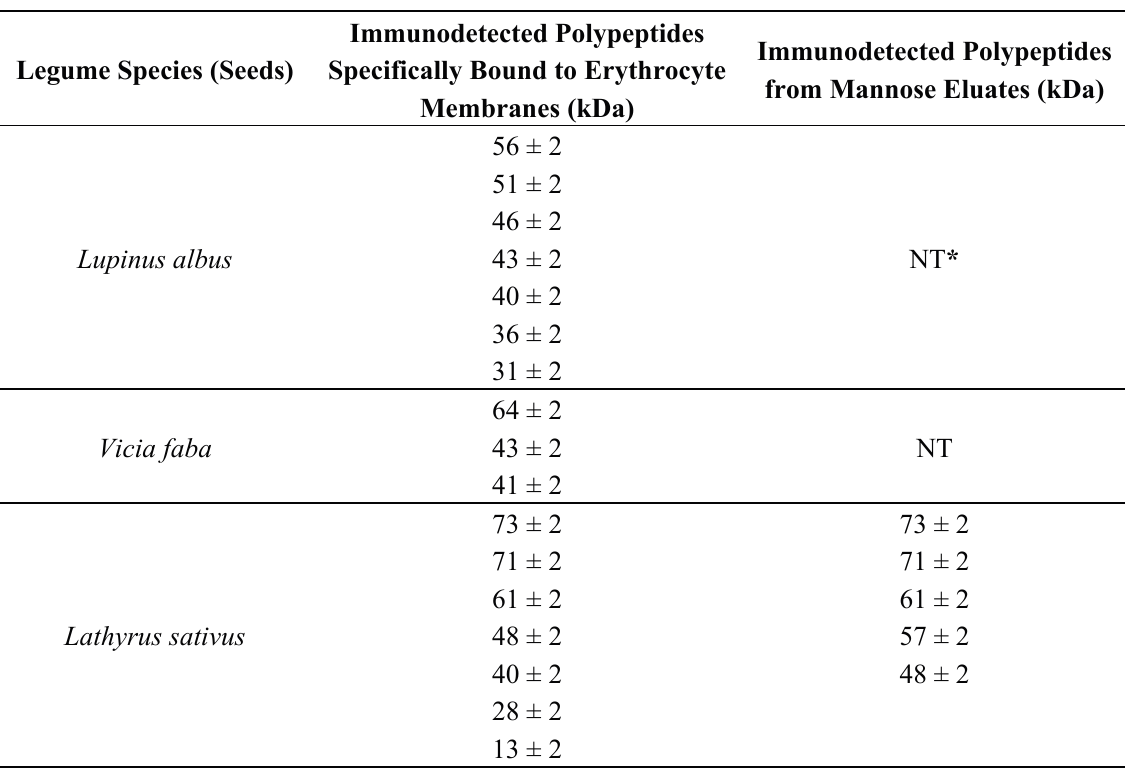
Table 2. Vicilin polypeptides from β -conglutin ( L. albus ), vicilin ( V. faba ) and β -lathyrin ( L. sativus ) which bound specifically to glycosylated epitopes present in rabbit erythrocyte